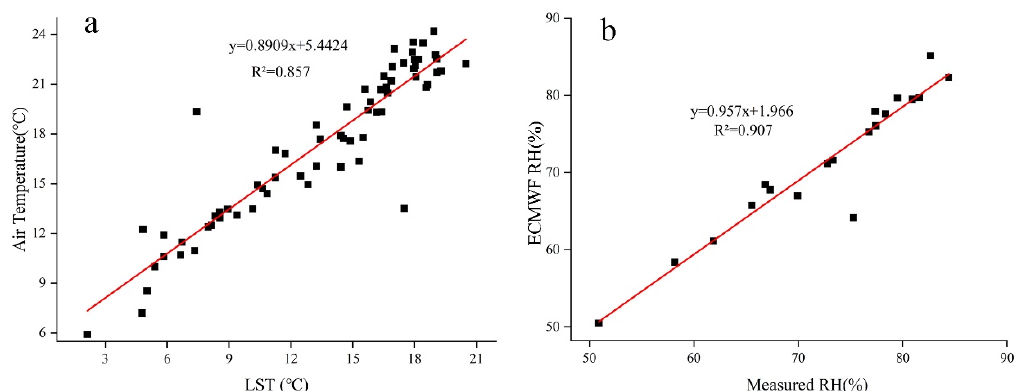
Figure 2. Regression analysis of air temperature and relative humidity. ( a ) The regression analysis of air temperature and LST; ( b ) The regression analysis of relative humidity data.